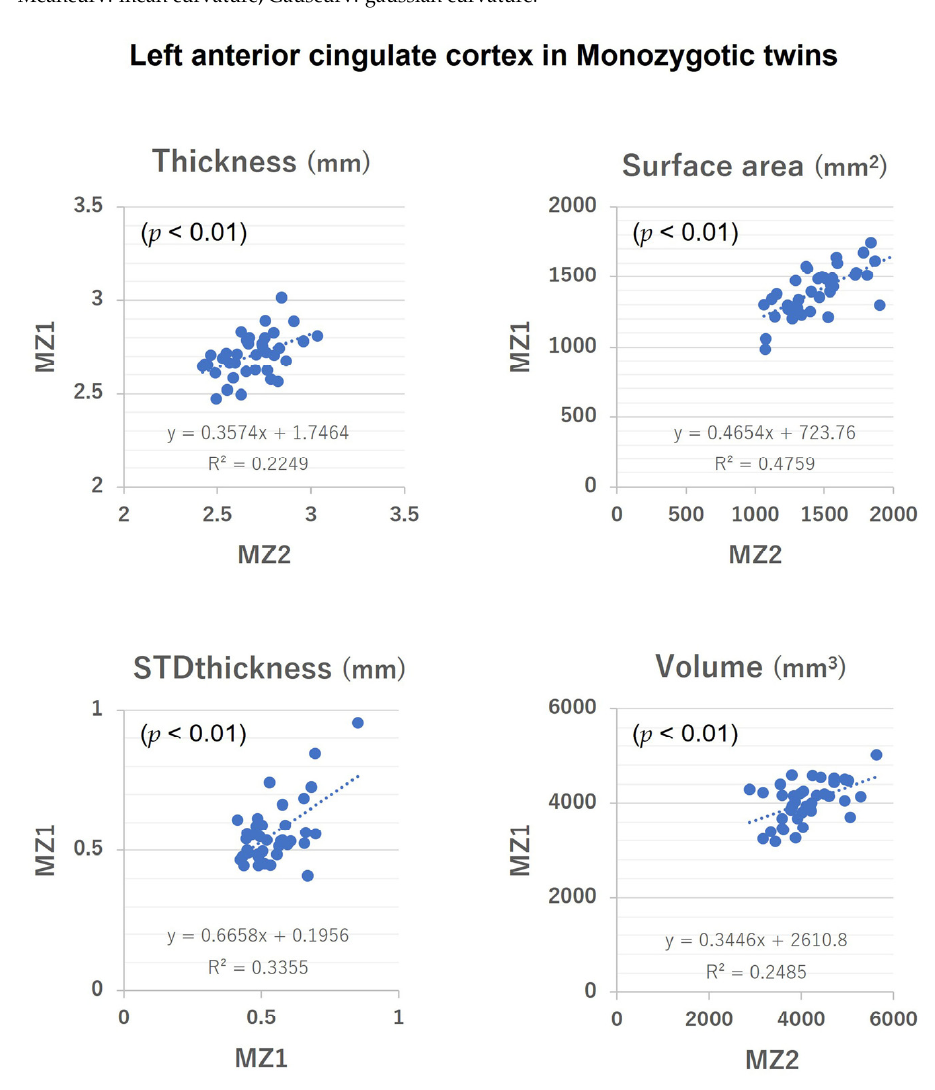
Figure 2. Intra-twin pair correlation of surface morphological parameter values (Thickness, Sur- face area, STDthickness and Volume) of the left anterior cingulate cortex in monozygotic twins. STDthickness: standard deviation of the